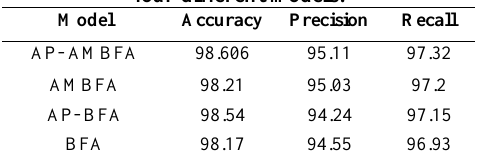
Table 5. Comparison of the results of three measures for four different models. Model